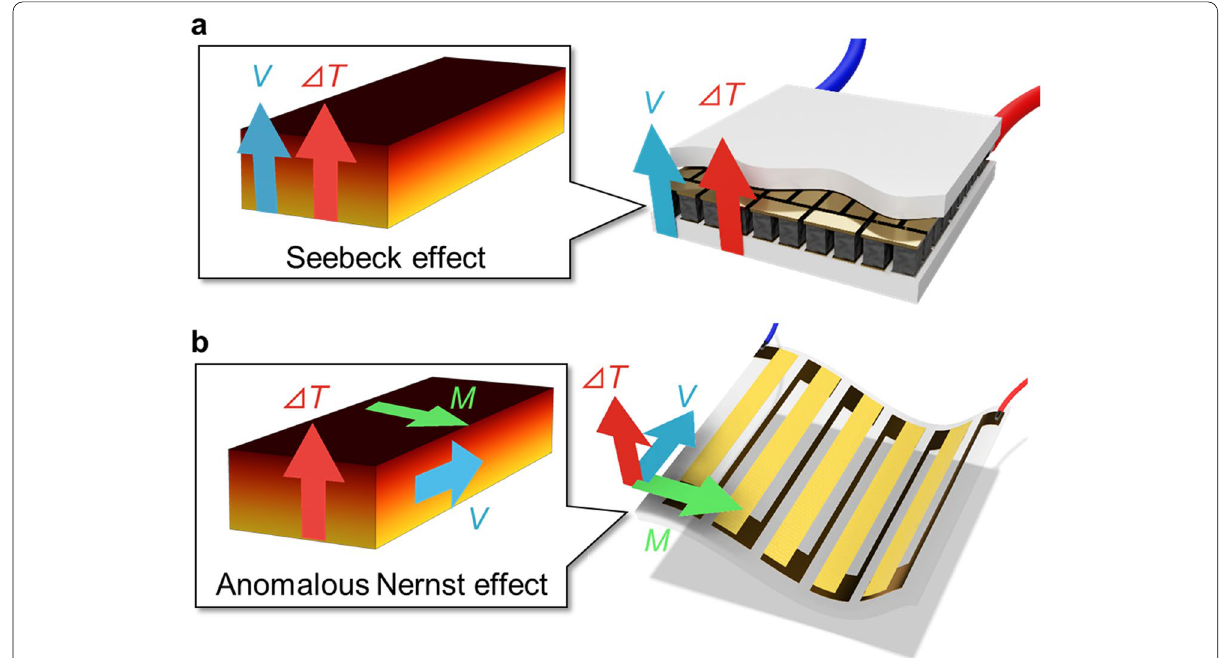
Fig. 6 a Conventional thermoelectric and b magneto-thermoelectric conversion technologies [16]. In conventional thermoelectric conversion (Seebeck effect), the electromotive force is generated along the same direction as the temperature difference, requiring a three-dimensional module structure. Conversely, the magneto-thermoelectric effect (anomalous Nernst effect) generates an electromotive force perpendicular to the temperature difference, enabling a simpler structure more applicable to thin-film